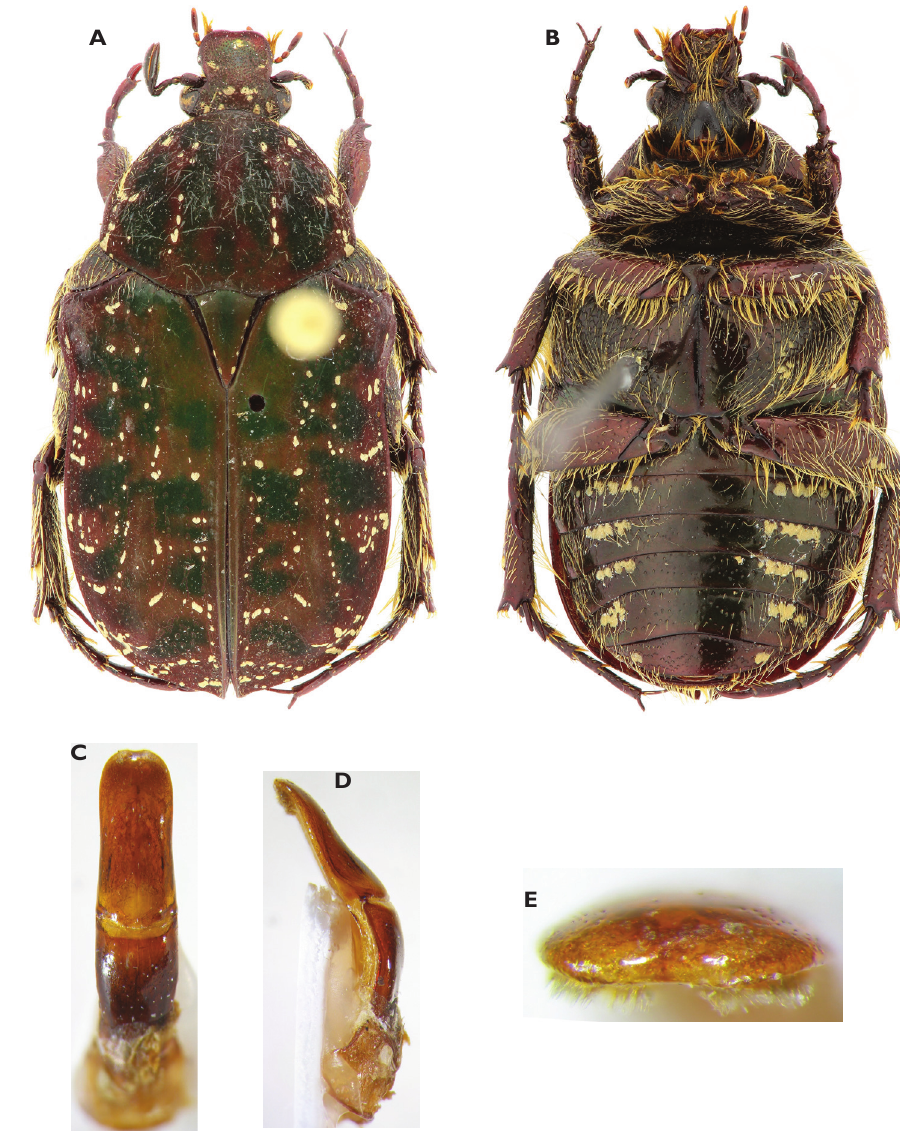
Figure 18. Atrichelaphinis ( Eugeaphinis ) bjornstadi sp. n., holotype (PCSR). A Dorsal view B ventral view C parameres in dorsal view D parameres in lateral view E apex of Legs. Metafemora sometimes with white spots of tomentum on underside close to joint; meso- and metatibiae with transverse carina just after middle; metatibial spurs thinner and more acute in male, larger and blunt in female. Aedeagus. Parameres forming slight concavity at middle of lateral margins; without projections at apex, but with marked incision at middle of downturning frontal margin.